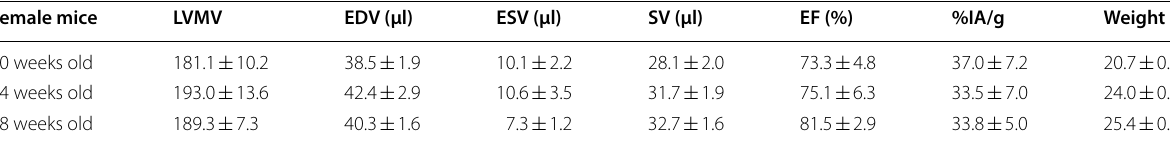
Table 2 Multiparametric longitudinal PET measurements in female mice